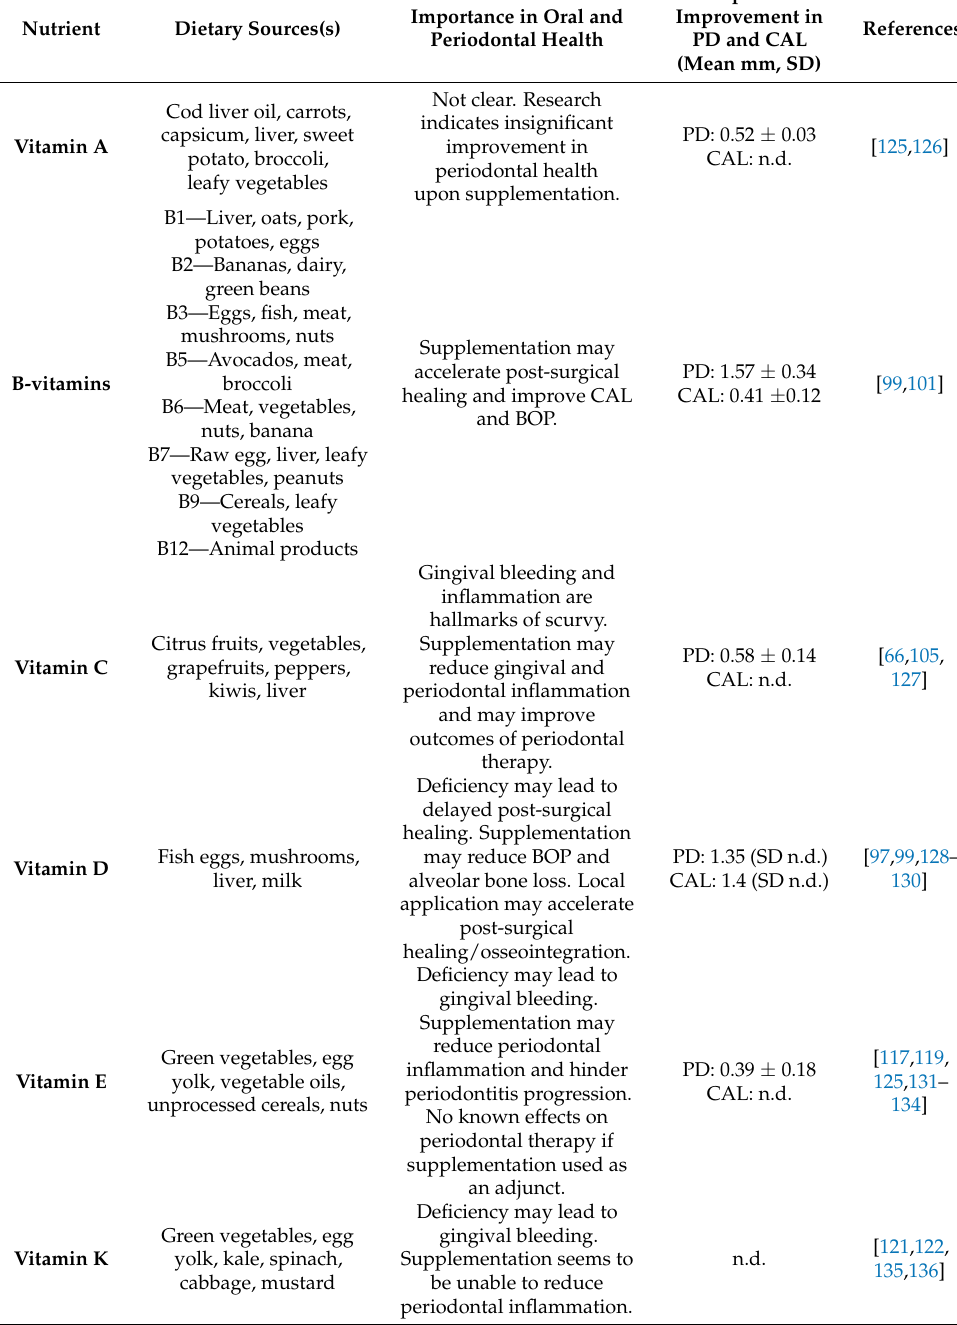
Table 2. Association between deficiencies of certain micronutrients and periodontal